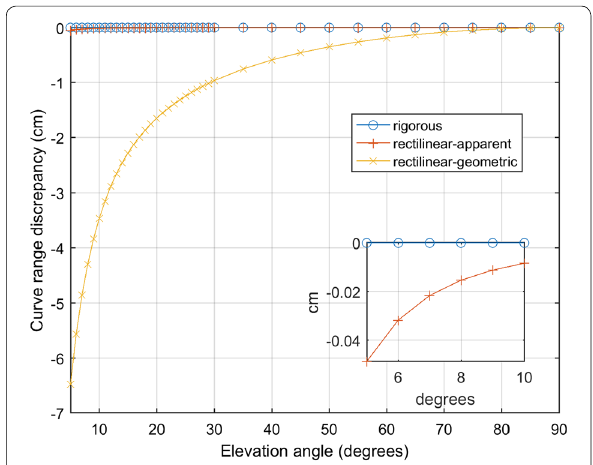
Fig. 3 Curve range discrepancy as a function of satellite elevation angle (for a fixed 10‑m reflector height)